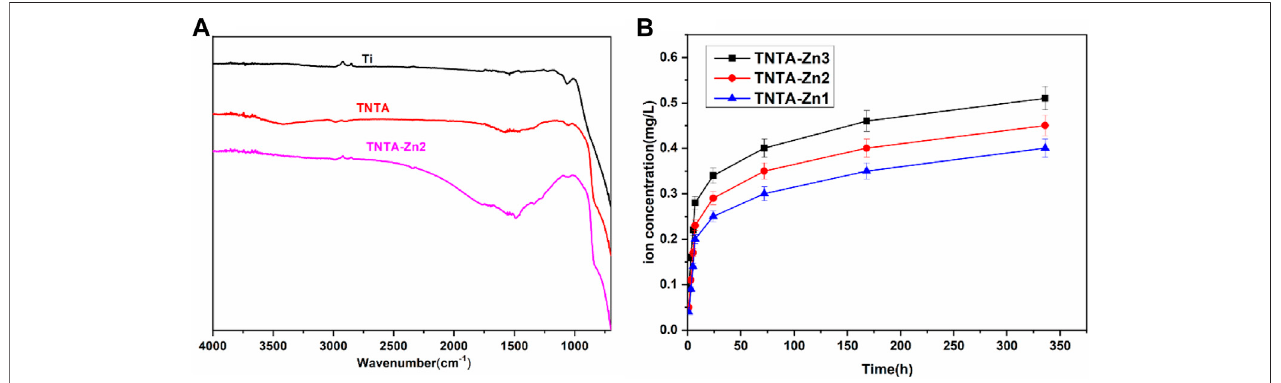
FIGURE 3 | FTIR spectra (A) of the different samples and the release pro fi les of zinc ions (B)